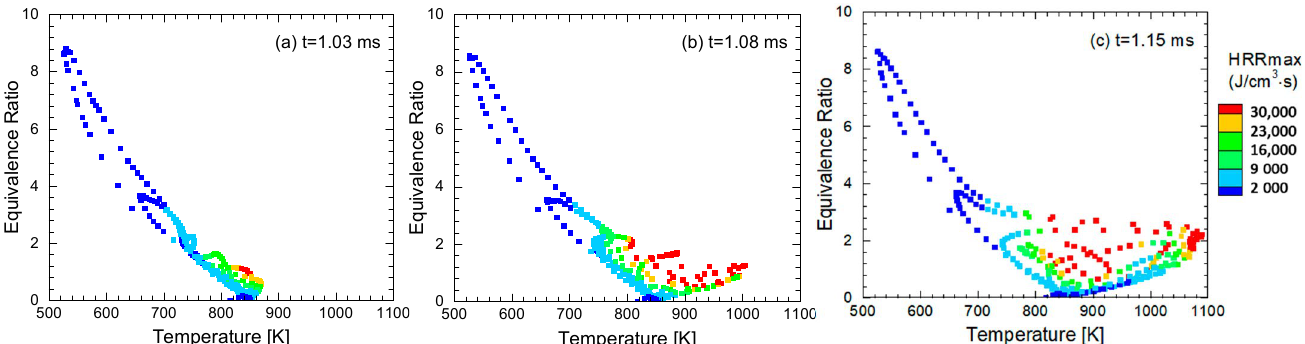
Figure 5. Φ -T diagram for 100 MPa injection pressure in CVB (ambient gas initial temperature 850 K, ambient oxygen concentration 21%, gas density 14.8 kg/m 3 ).